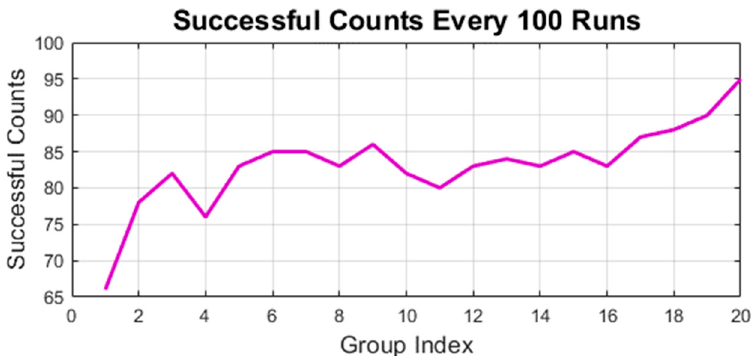
Figure 7. RL learning performance.